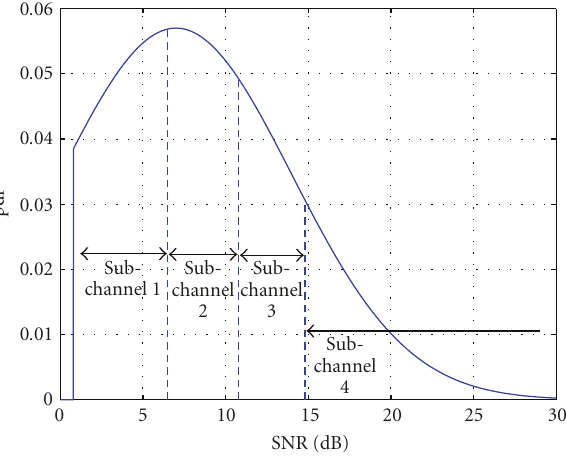
Figure 2: Distribution of SNR in frequency tones of the power- line channel. Frequency tones are grouped into four subchannels according to their